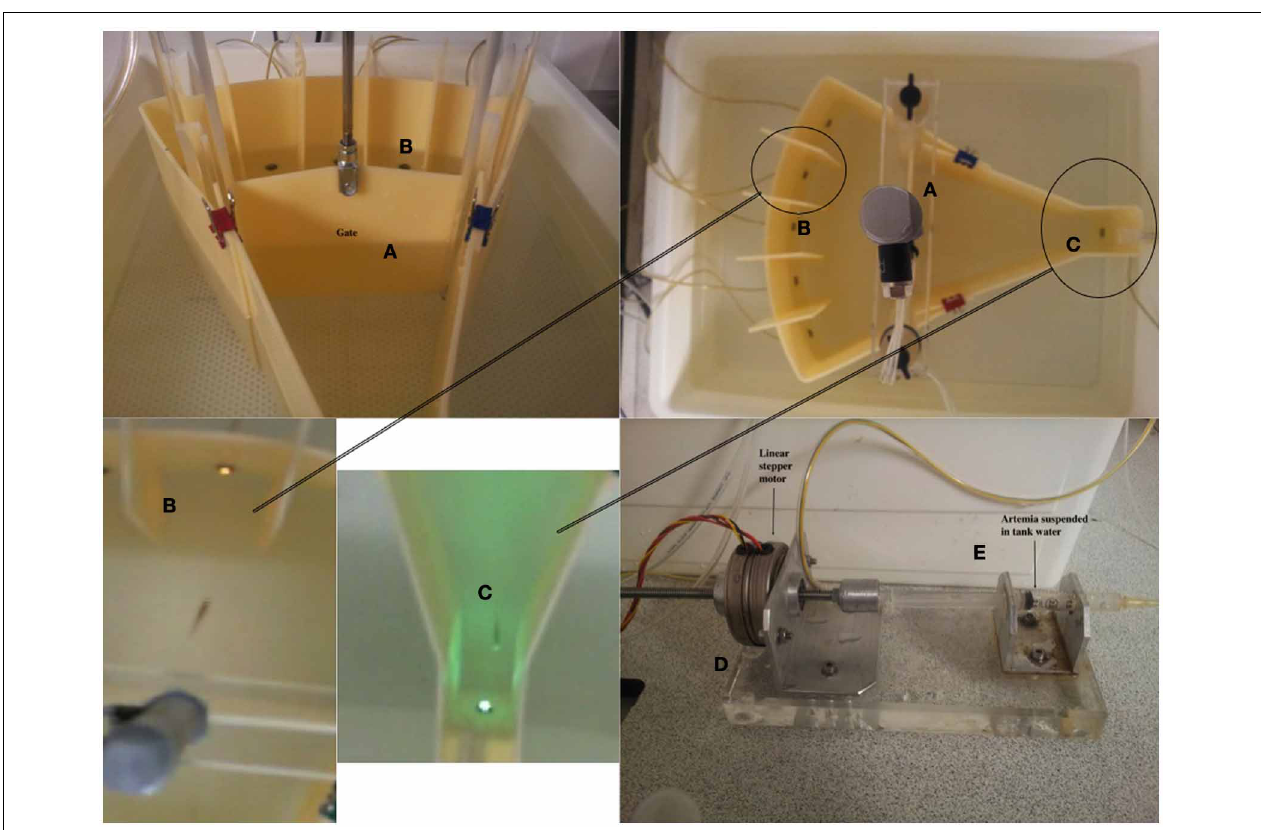
FIGURE 1 | Figure displays the testing unit and the constituent parts. (A) The pneumatic gate mechanism. (B) The stimulus light area. The stimuli were 5 white LEDs. (C) The food delivery area and magazine. This comprised a green LED to act as a stimulus to signal